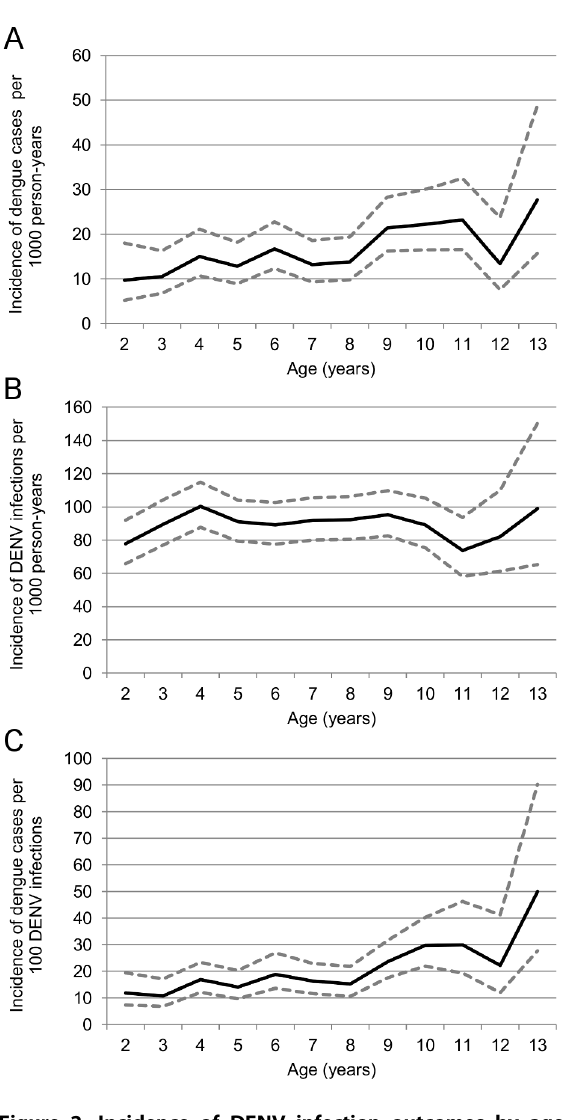
Figure 2. Incidence of DENV infection outcomes by age. A. Dengue cases per 1,000 person-years at risk. B. DENV infections per